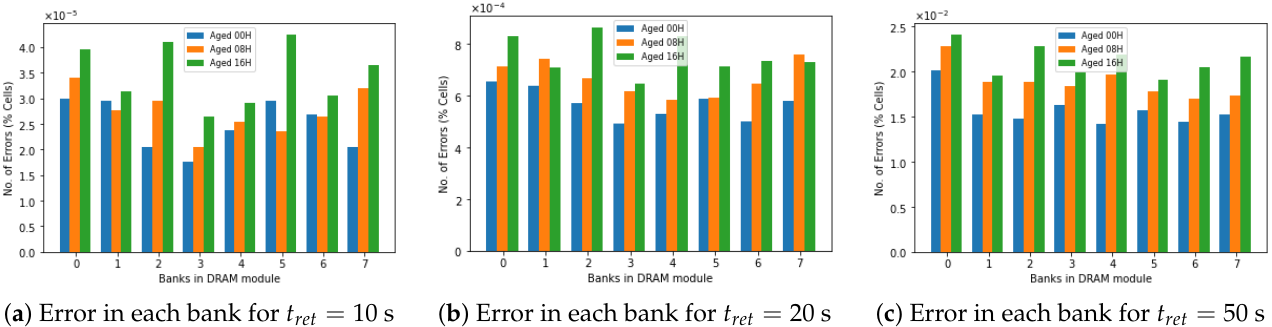
Figure 6. Retention error for 0x00 pattern in each bank with aging in a Hynix 2GB DRAM